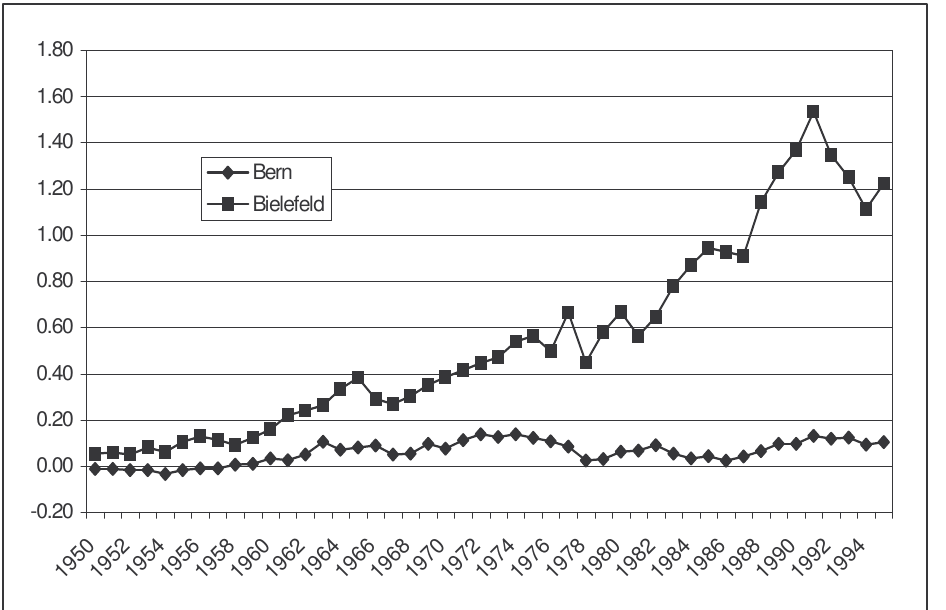
Figure 8. Public transport: comparison Berne – Bielefeld, deficit/trip in SFR/DM (prices of